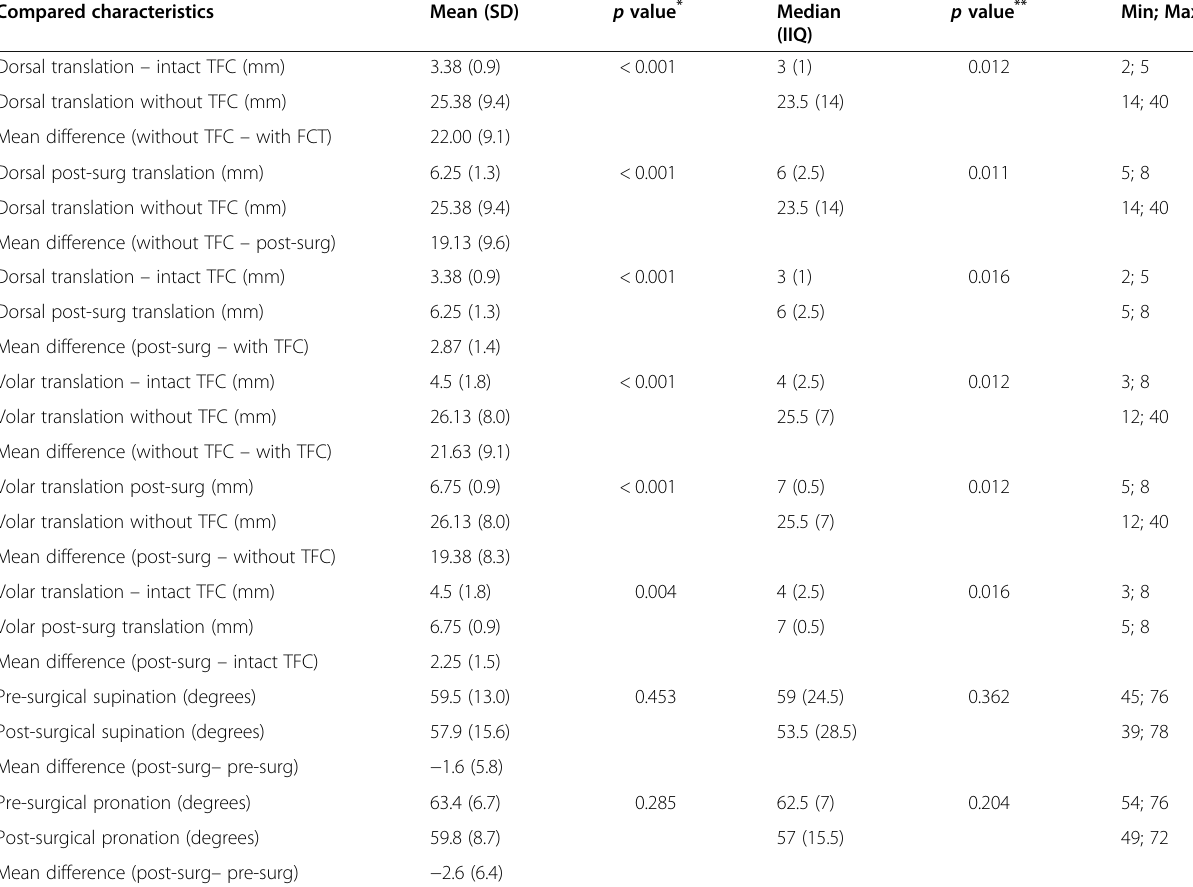
Table 2 Compared characteristics (translation and pronosupination) Compared